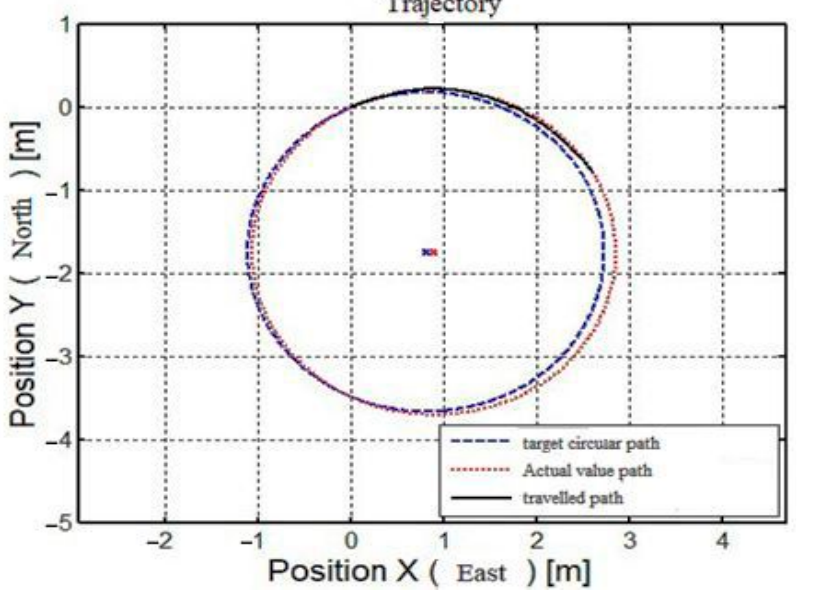
Figure 8. Driven trajectory in the X-Y